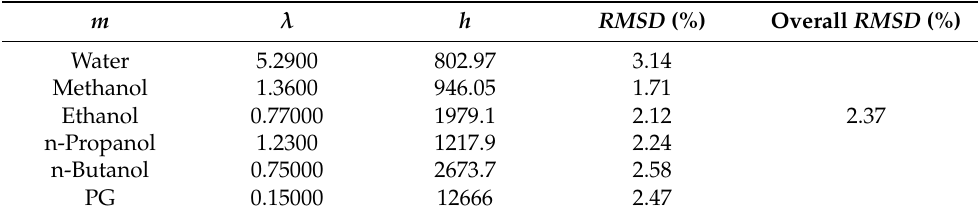
Table 8. The results of the Buchowski–Ksiazczak λ h model for TRV in six different